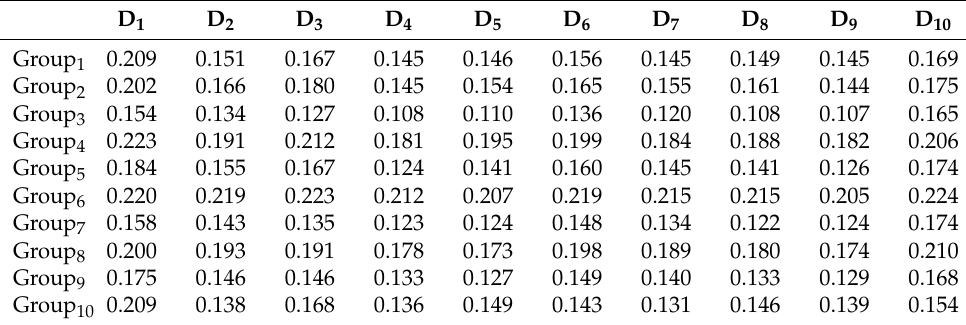
Table 10. Aggregated distances with Minkowski.